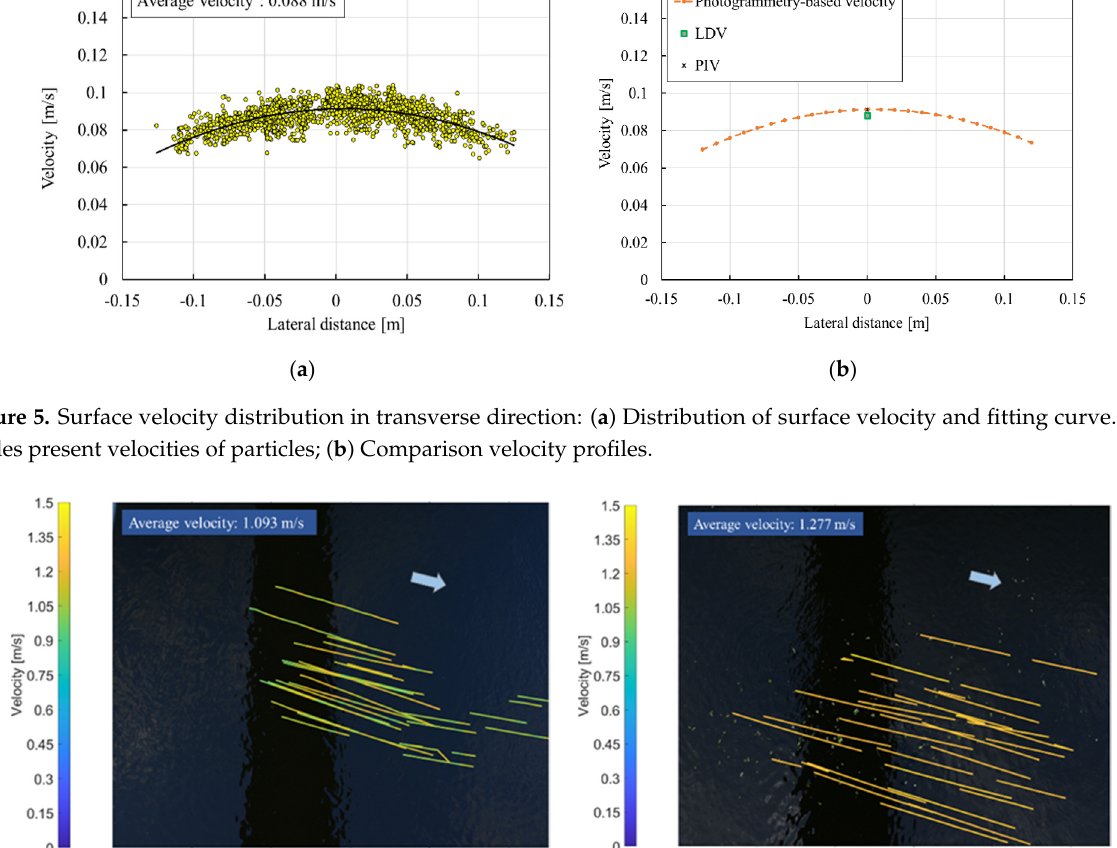
Figure 4. Surface flow velocity field of the laboratory flume measurement.